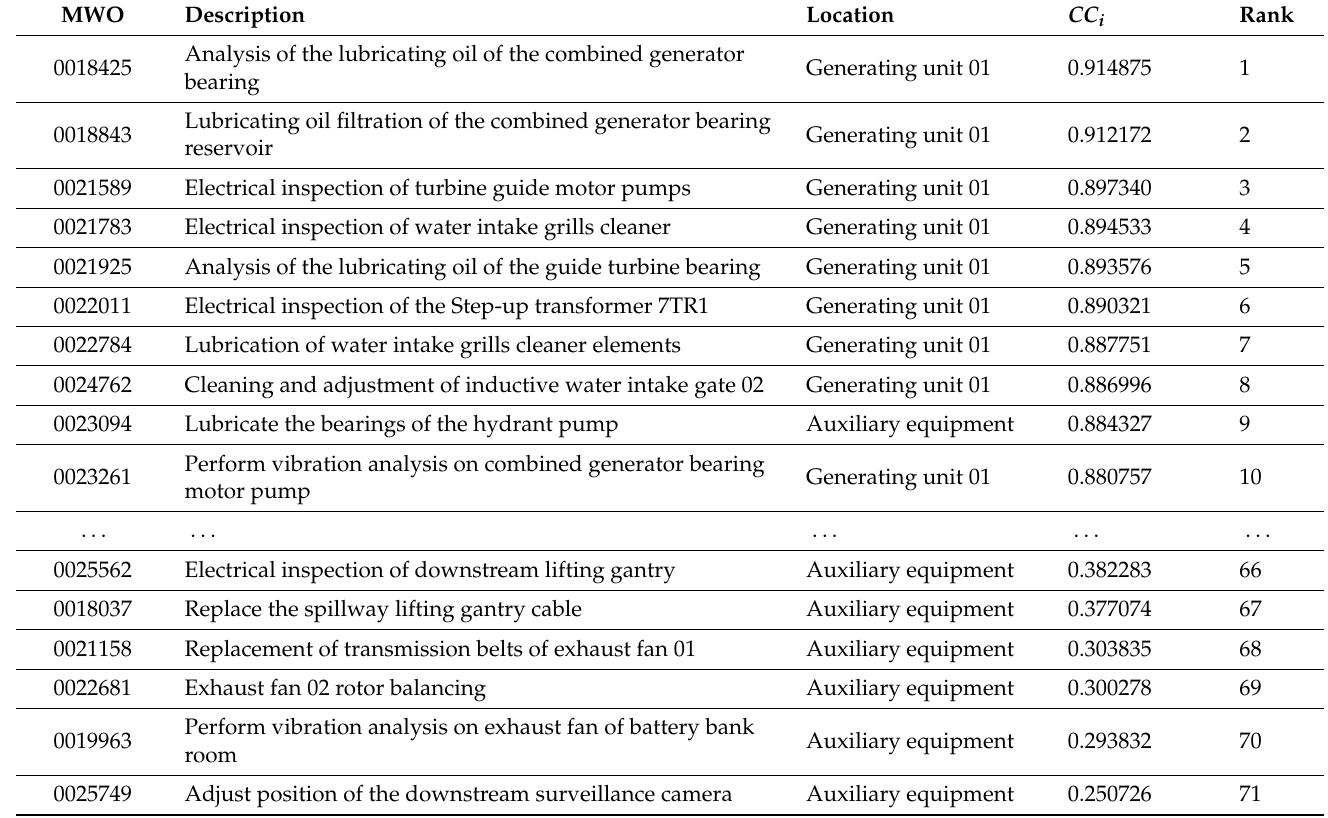
Table 10. Ranked maintenance work orders after the TOPSIS